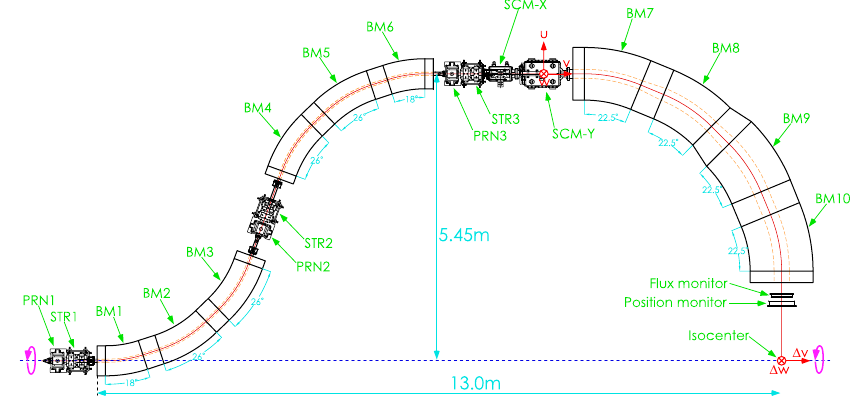
FIG. 2. Layout of the superconducting rotating gantry. The gantry consists of ten superconducting magnets (BM1-10), a pair of the scanning magnets (SCM-X and SCM-Y), and three pairs of beam profile-monitor and steering magnets (STR1-3 and PRN1-3).